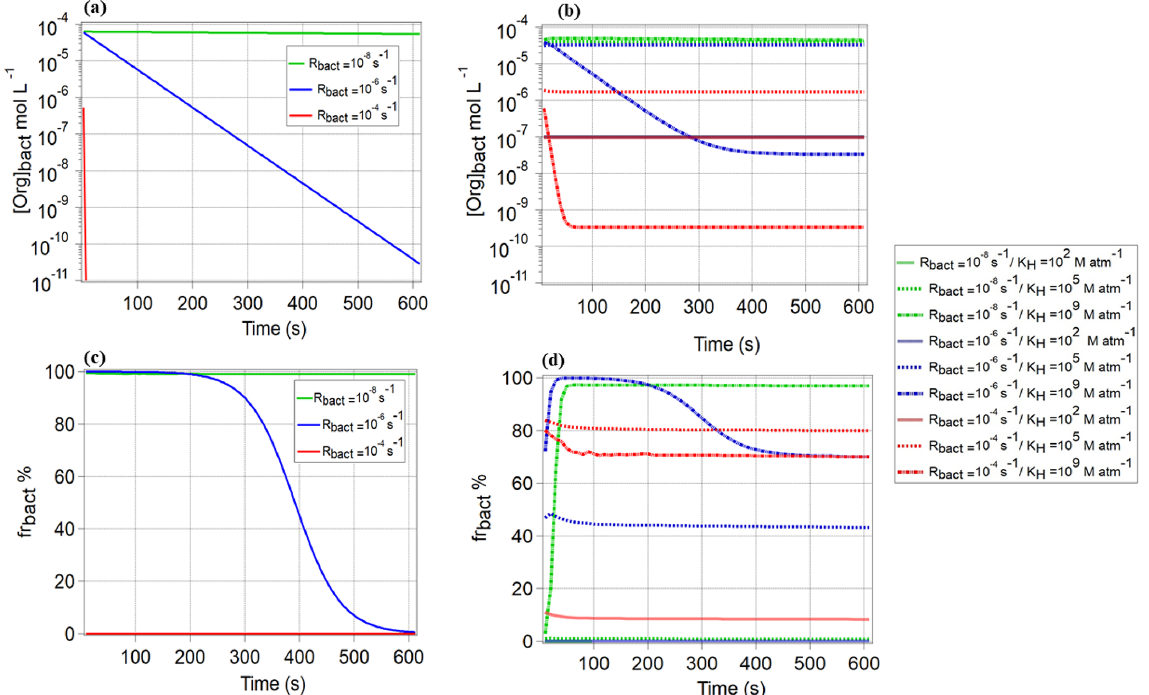
Figure 4. Comparison of the organic concentration in the bacteria-containing droplets [Org] bact [molL − 1 ] for (a) CCN-derived compounds, (b) water-soluble organic gases ( K H = 10 2 , 10 5 and 10 9 Matm − 1 ), and (c, d) the resulting fr bact for these compounds. Results are shown for R bact = 10 − 8 , 10 − 6 , and 10 − 4 s − 1 ; R chemgas = 10 − 6 s − 1 ; and R chemaq = 10 − 11 s − 1 .